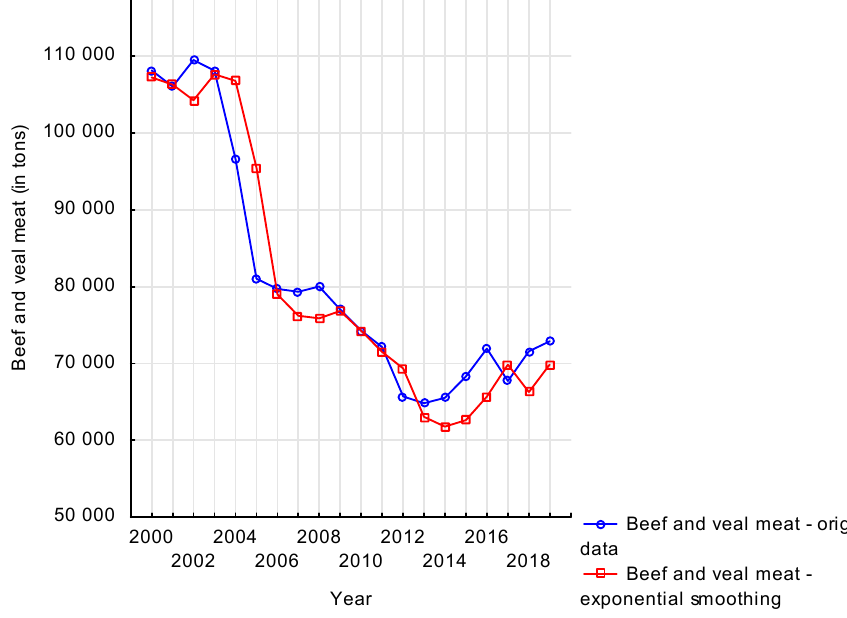
Figure 6. Beef and veal meat production in the Czech Republic (in tons) [27].